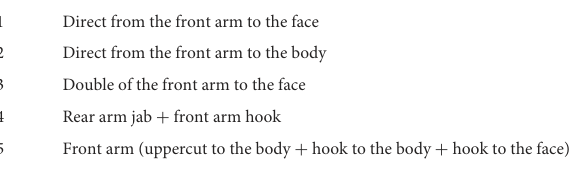
TABLE 2 Boxing trials and their specific